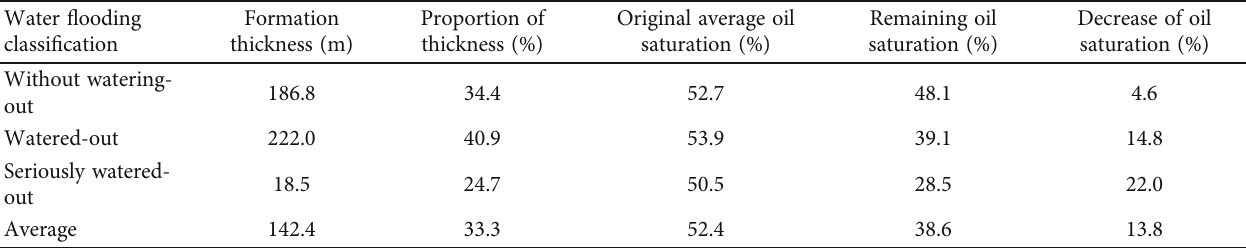
Table 2: Statistical analysis of water fl ooding in Chang 6 layer.